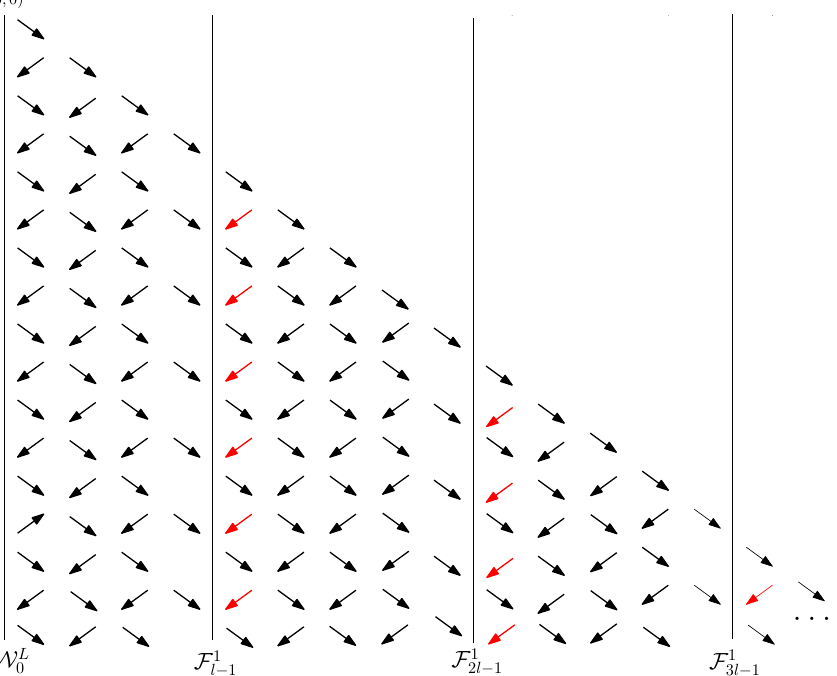
Figure 4. Arrangement of steps for points of L in the considered, slightly tweaked version of the auxiliary lattice path model. Here, we depict the case, where l =